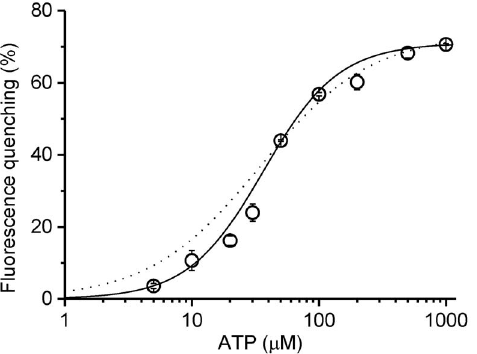
Figure 3. Titration of fluorescence by ATP. Changes in the fluorescence upon addition of ATP are expressed as percent of the fluorescence before the addition of ATP. Values are taken when the fluorescence reached a plateau. Error bars represent standard errors. The solid line represents the theoretical curve with the Hill equation (Fluorescence quenching = D FL max 6 [ATP] n /( K d n + [ATP] n )) with the fol- lowing parameters( 6 standard error); K d = 36.5 6 1.2 m M, D FL max =71.0 6 0.7%, n =1.47 6 0.1. The dotted line represents the theoretical curve with simple binding equation (Fluorescence quench- ing = D FL max 6 [ATP]/( K d + [ATP])) with K d = 34.4 6 2.9 m M, D FL max =73.5 6 1.5%.